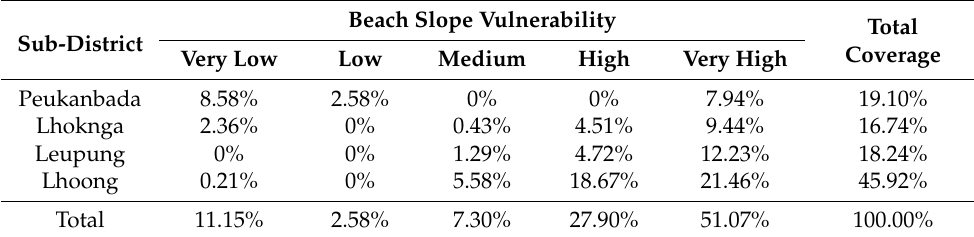
Table 6. Percentage of coastal vulnerability in terms of coastal slope .